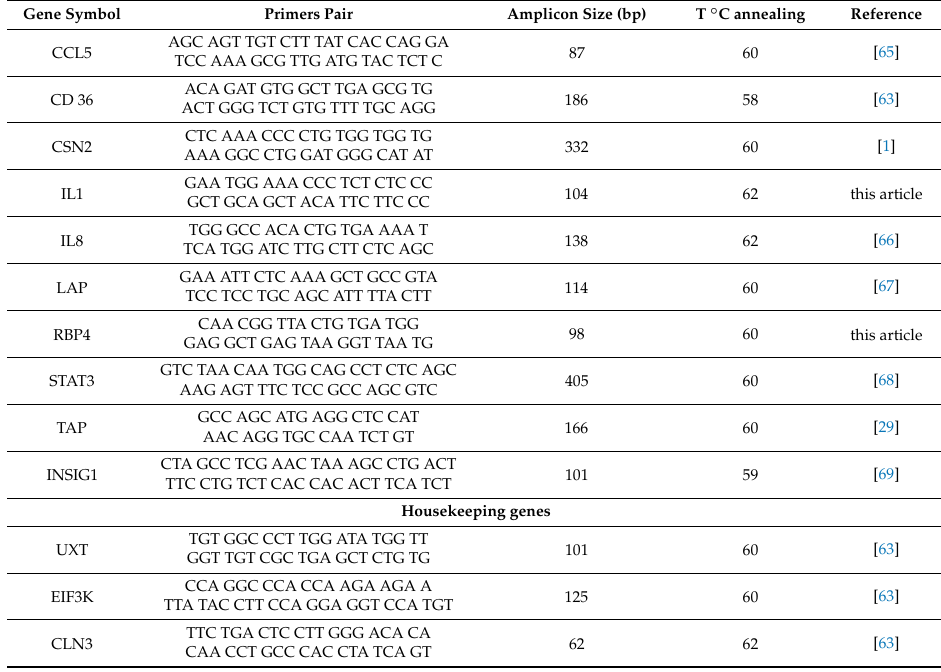
Table 3. Primer sequences and annealing temperatures used in real-time reverse transcription-PCR assays as the size of the amplicons (in